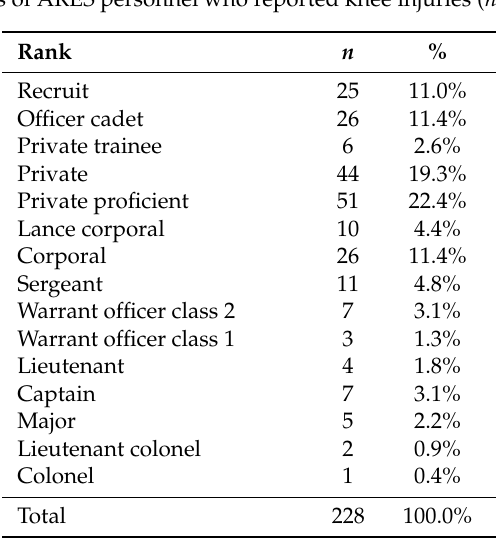
Table 7. Military ranks of ARES personnel who reported knee injuries ( n = number of injuries). Rank n %